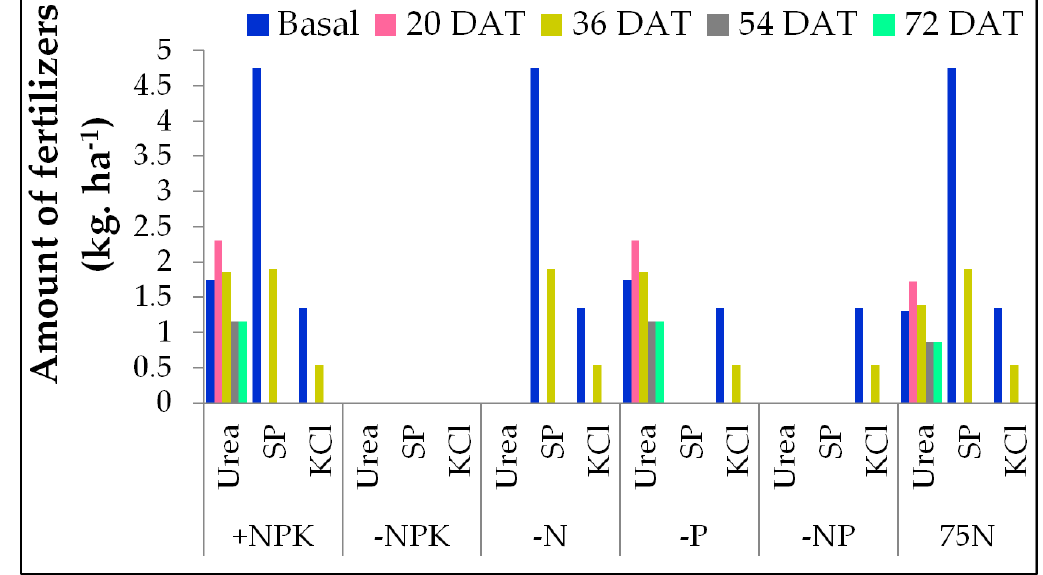
Figure 4. Application of fertilizers in six NuUE conditions with five splits.